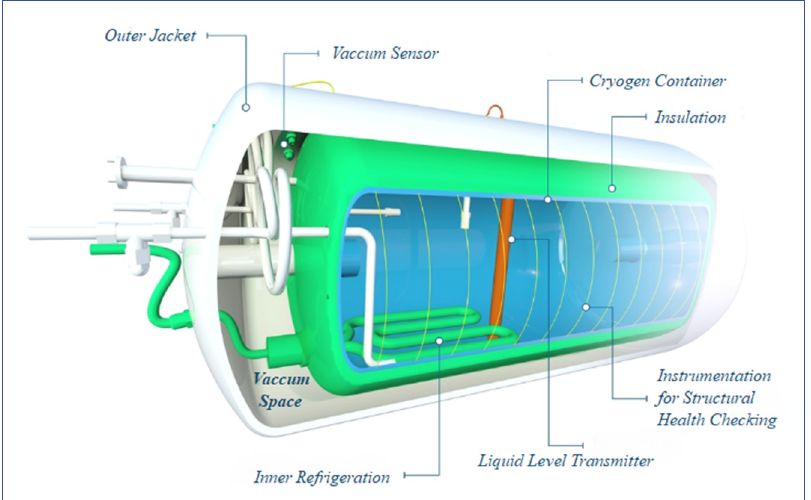
Figure 1. An active refrigerated liquid hydrogen vacuumed pressure vessel cross-sectional drawing [35].